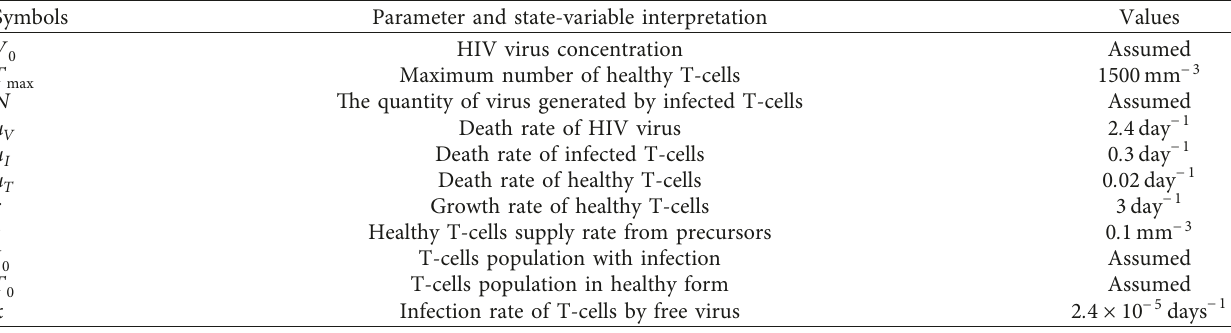
Table 1: Description of state-variables and input parameters with corresponding